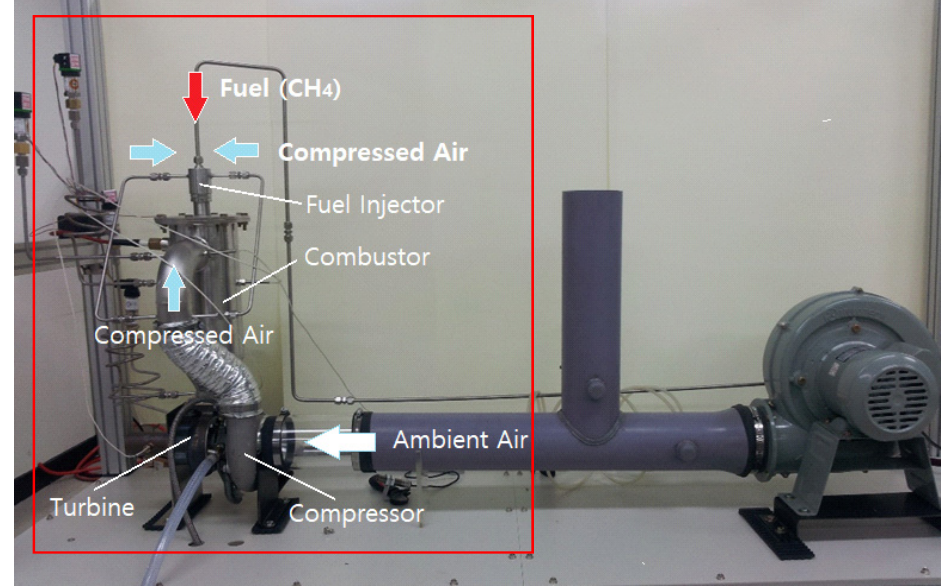
Figure 1. Photo of the test rig of the 300 kW model micro gas turbine engine.